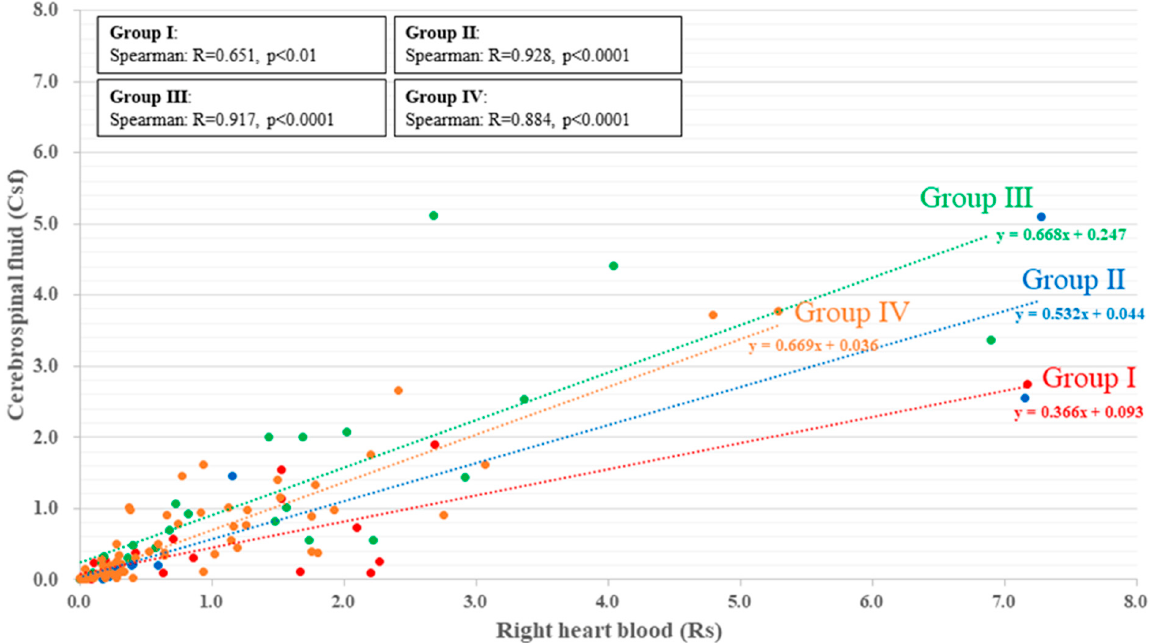
Figure 2. The correlation between the concentration of caffeine in Rs and that in CSF in Groups I (red), II (blue), III (green), and IV (orange). There is a correlation between the concentration of caffeine in Rs and in CSF in all groups (Group I: r = 0.651, p < 0.01; Group II: r = 0.928, p < 0.0001; Group III: r = 0.917, p < 0.0001; Group IV: r = 0.884, p < 0.0001). The concentration of caffeine is higher in Rs than in CSF in Groups I and II.